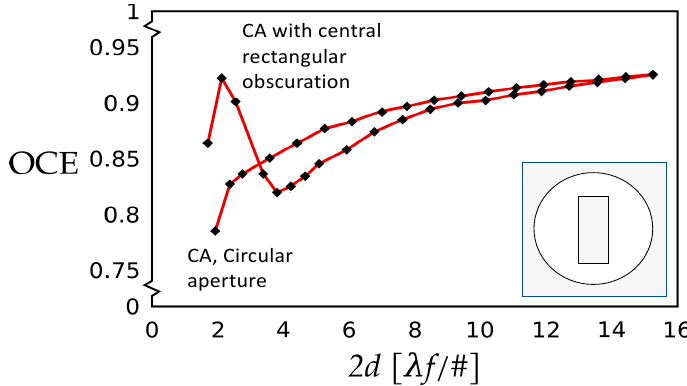
Figure 11. The OCE as a function of pixel size in [ λ F/# ] for an optical system with and without a central rectangular obscuration. A sharp increase in the OCE value toward the first peak at about 2.05 pixels is followed by a sharp dip at about 4 pixels only for the case of the circular aperture with a central obscuration. The OCE curve for a circular aperture without a central obscuration increases in a monotonical fashion. CA denotes a circular aperture.